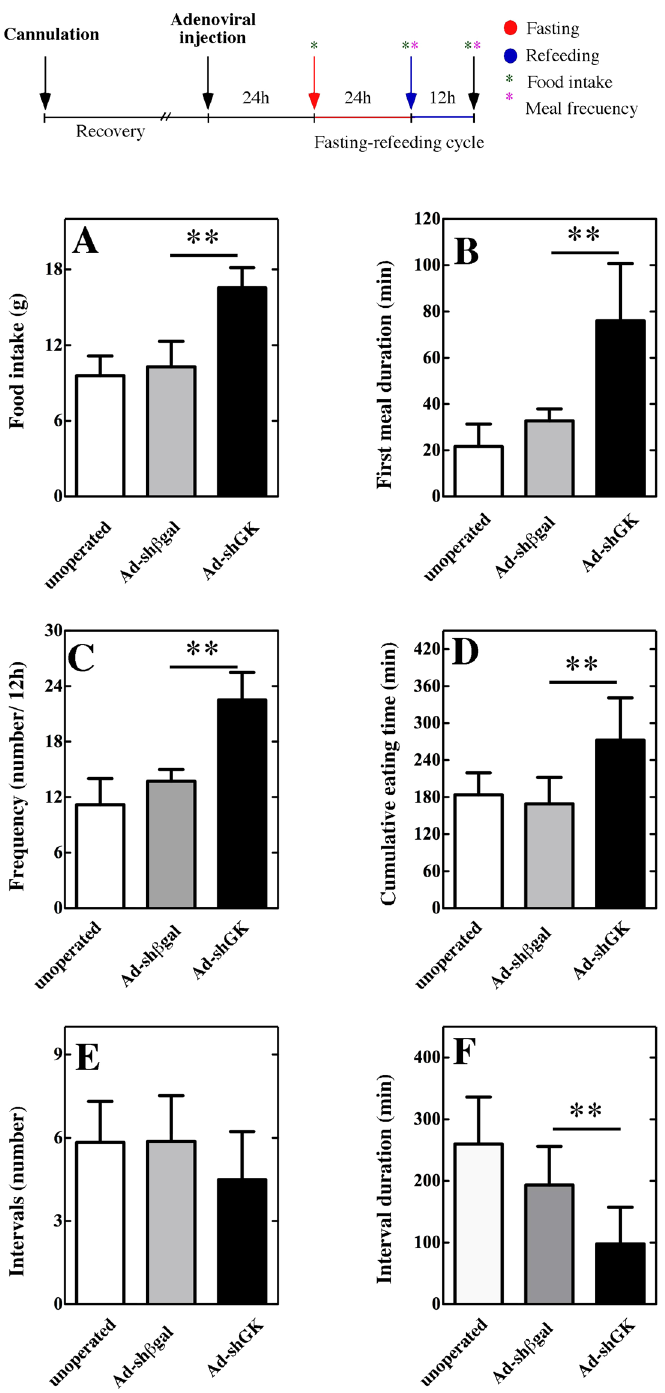
Figure 6. Effect of GK knockdown on feeding behavior in control and GK knockdown animals. ( A–F ) Food intake ( A ), first meal duration ( B ), frequency of eating events ( C ), cumulative eating time ( D ), intervals and interval duration ( F ) were evaluated in unoperated, Ad-EGFP-injected (Ad-EGFP) and Ad-shGK-injected animals (Ad-shGK). Schematic representation of the experimental procedure is shown in the top. Statistics: non-parametric ANOVA; ** p <